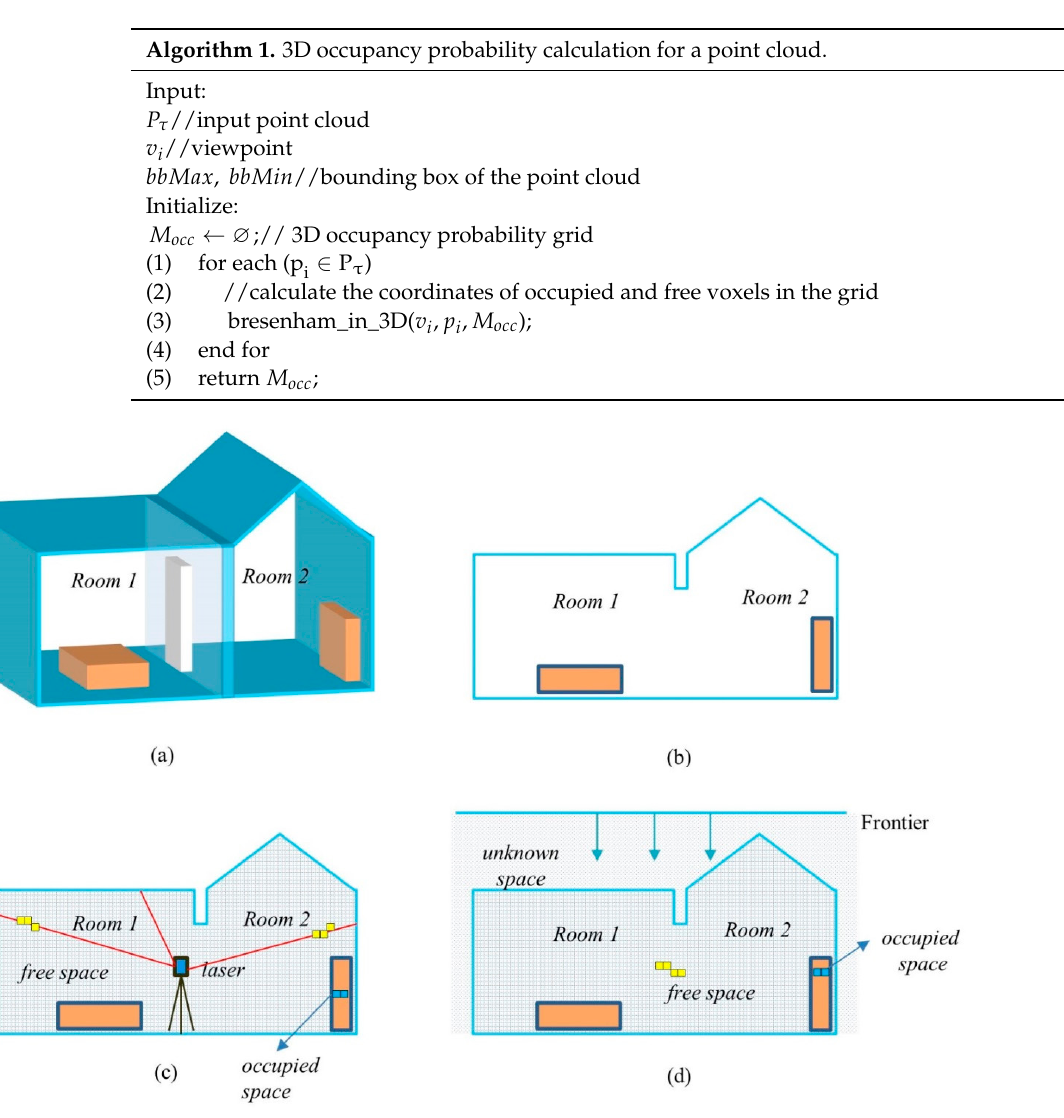
Figure 2. Example of voxelization of an indoor space: ( a ) door separating two rooms; ( b ) profile of the indoor space; ( c ) point cloud acquisition using laser scan, where the voxels are marked as free spaces and occupied spaces are colored yellow and blue; ( d ) voxelization for a mesh without poses/viewpoints , frontier is used to mark unknown voxels.